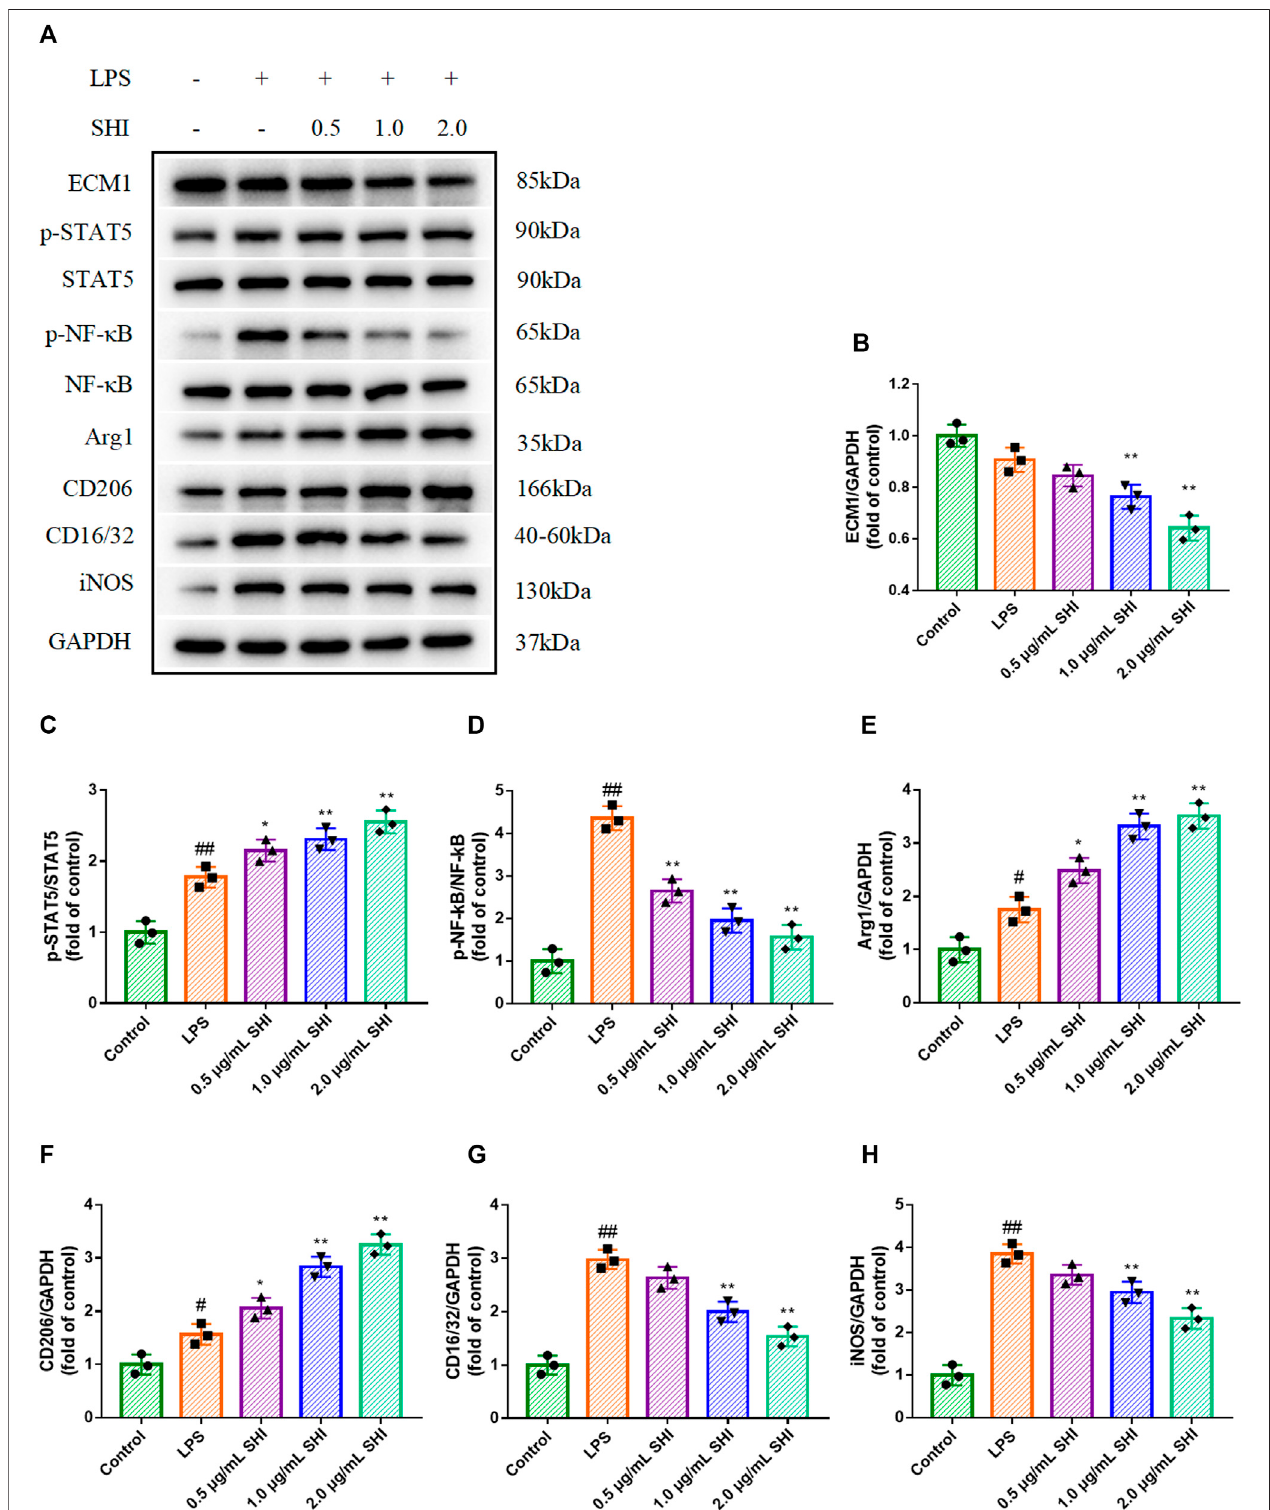
FIGURE 4 | The effect of SHI on ECM1/STAT5/NF- κ B signaling in LPS-induced RAW264.7 cells. The cells were treated with SHI (0.5, 1.0, and 2.0 μ g/ml). About 2 hlater,thecellswerestimulatedwithLPS(5 μ g/ml)for24 h. (A – H) TheproteinexpressionsofECM1,p-STAT5,STAT5,p-NF- κ B,NF- κ B,Arg1,CD206,CD16/32,and iNOSofLPS-inducedRAW264.7cells.Thedataareexpressedasmean±SD.Comparedwithcontrol: # p < 0.05, ## p < 0.01.ComparedwithLPS:* p < 0.05,** p < 0.01.